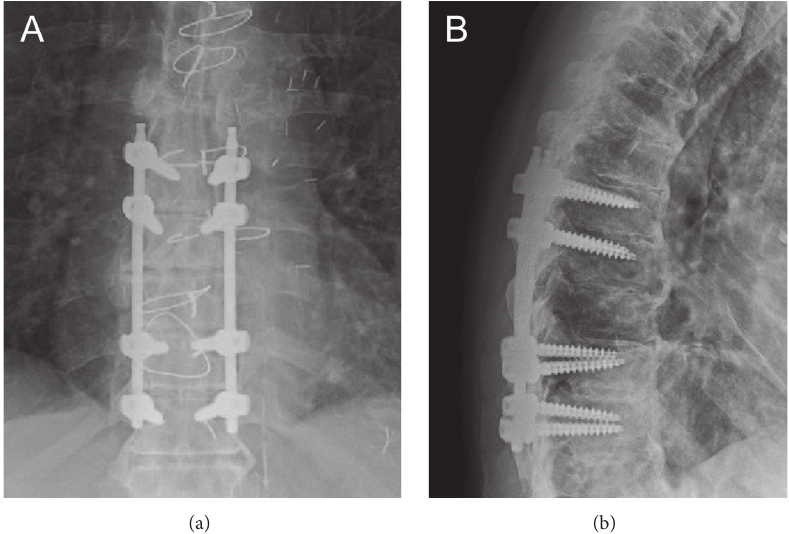
Figure 6: Postoperative thoracic spine X-rays ((a) anteroposterior; (b) lateral) at 3-month follow-up visit showing T7–T11 posterior fixation.